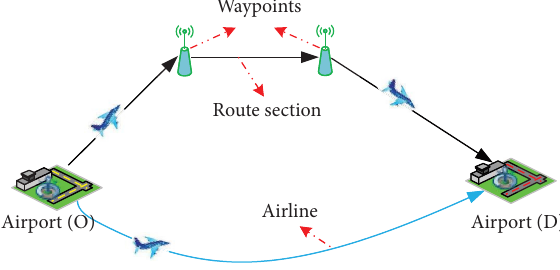
Airport (O) Figure 1: Diagram of the air